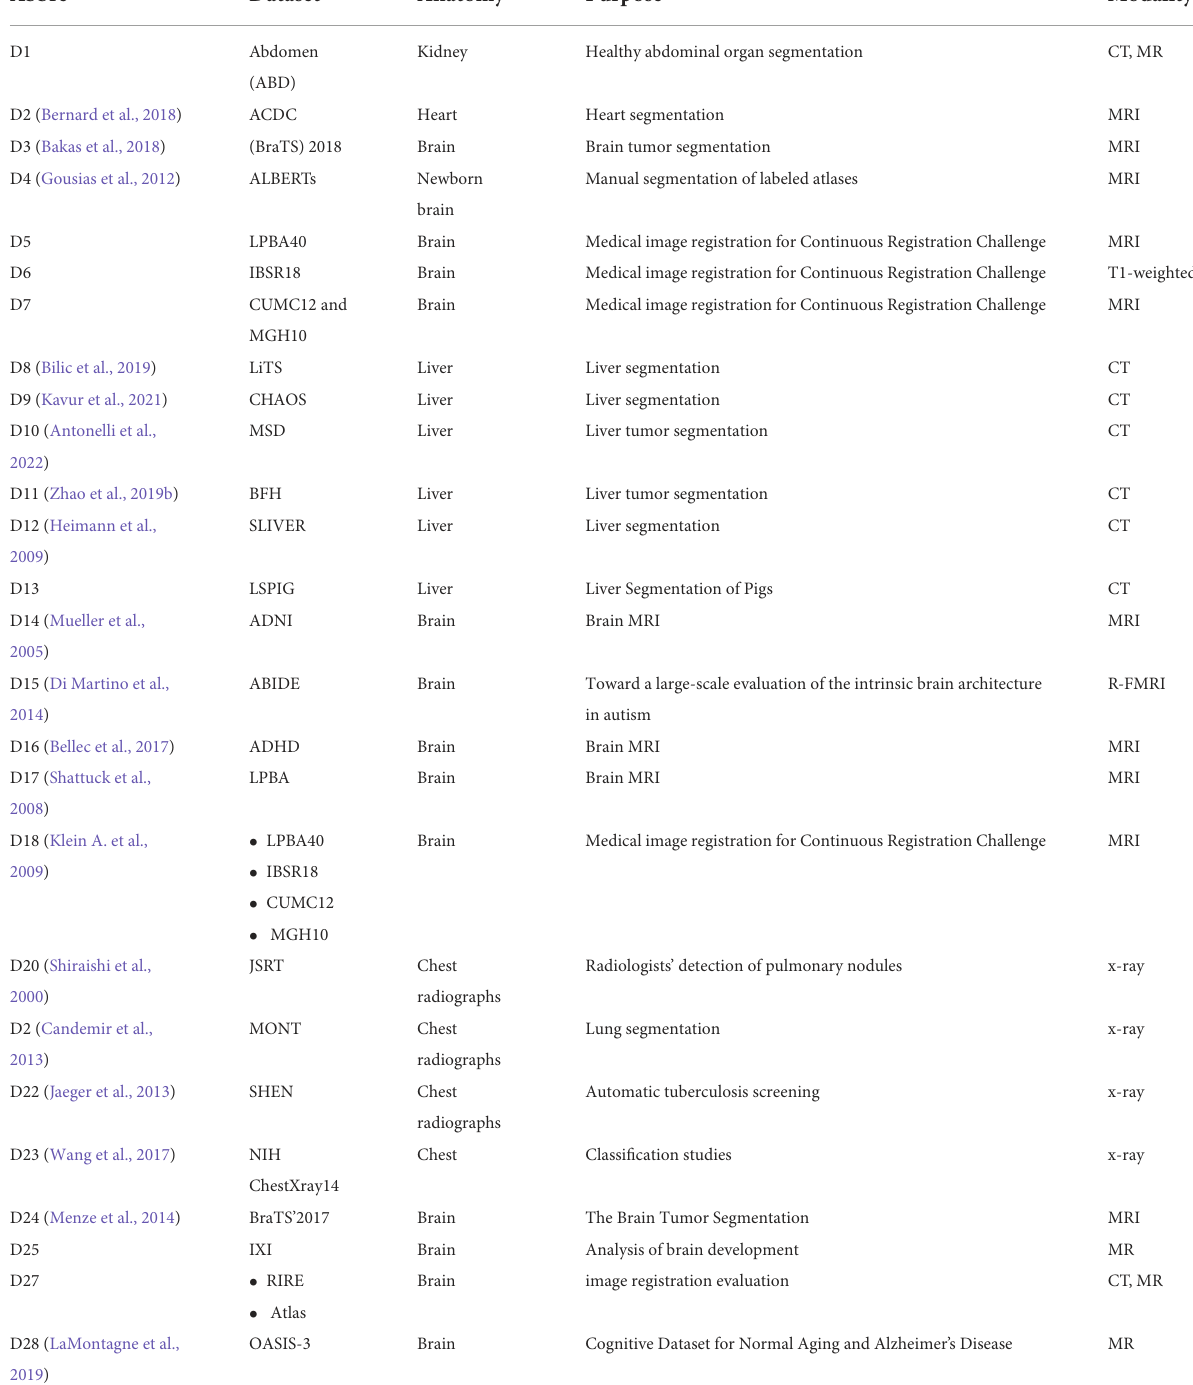
TABLE 8 Common datasets used in the reviewed